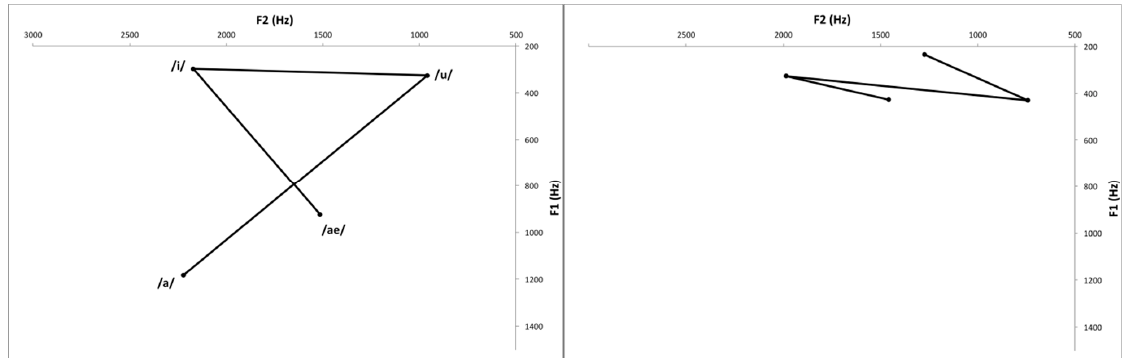
Figure 2. Distortion of acoustic vowel space.